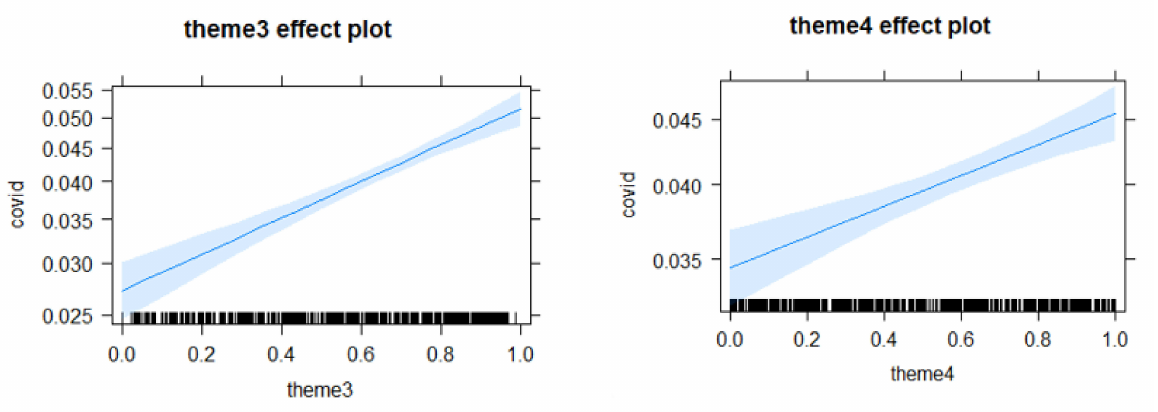
Figure A2. Predicted probability plots with 95% confidence interval by each